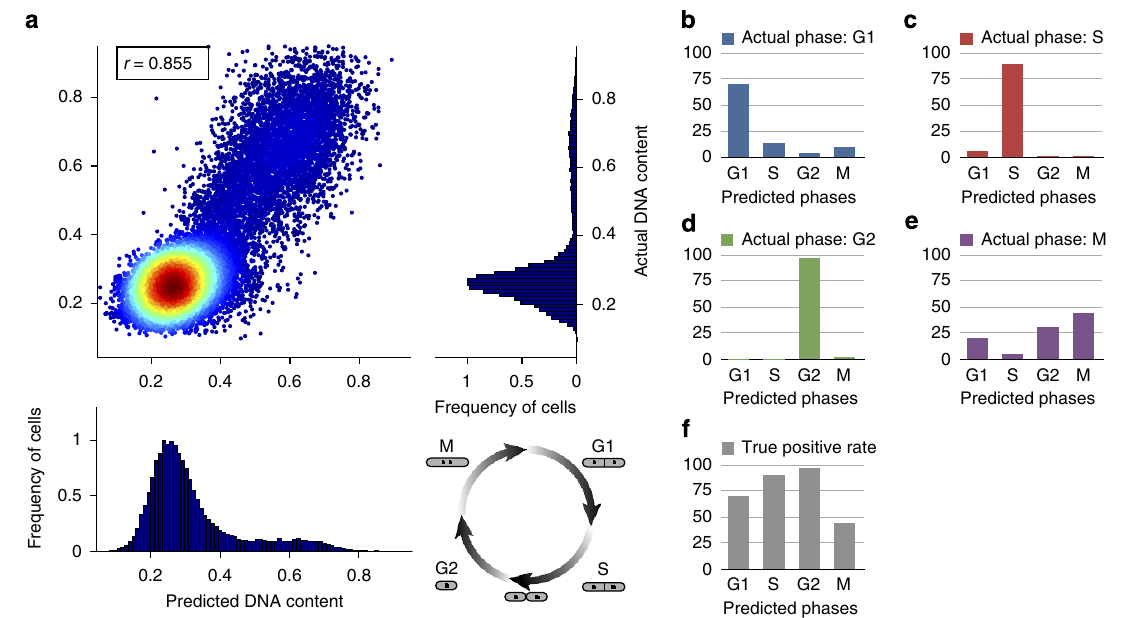
Figure 5 | Label-free prediction of DNA content and cell cycle phases for fission yeast cells. ( a ) Based only on brightfield and darkfield features, we find a Pearson’s correlation of r ¼ 0.855 ± 0.006 (error bars indicate the s.d. obtained via 10-fold cross-validation) between actual DNA content and predicted DNA content using regression (see Methods section). Note that the fission yeast cell cycle is different from the Jurkat cell cycle since the two daughter cells divide between the S and G2 phases (and not at the end of M phase as is the case for Jurkat cells). ( b – e ) For cells that are actually in a particular phase (for example, b shows cells in G1), the bar plots show the classification results (see Methods section) (for example, b shows that the cells in S, G2 and M are errors). ( f ) Bar plot of the true positive rates of the cell cycle classification. Using boosting with random undersampling to compensate for class imbalances, we obtain true positive rates of 70.2 ± 2.2% (G1), 90.1 ± 1.1% (S), 96.8 ± 0.3% (G2) and 44.0 ± 8.4